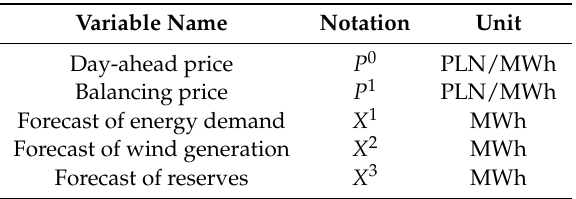
Table 1. Notation for the